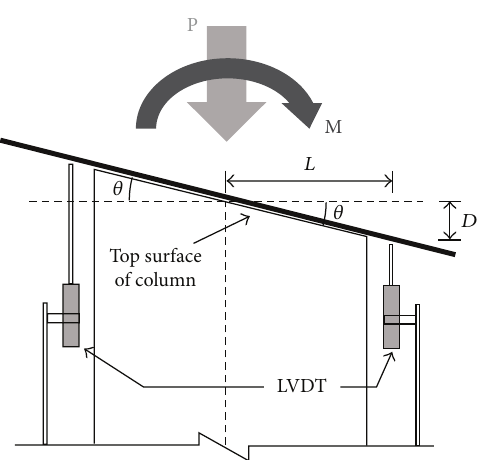
Figure 8: Axial force and flexural moment induced by minimum